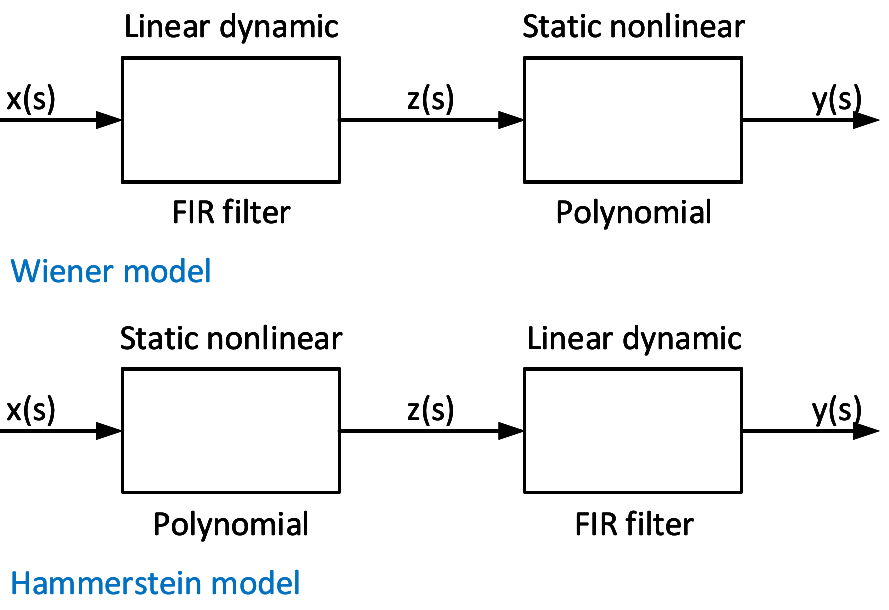
Figure 4. The block diagram for the Wiener model and Hammerstein